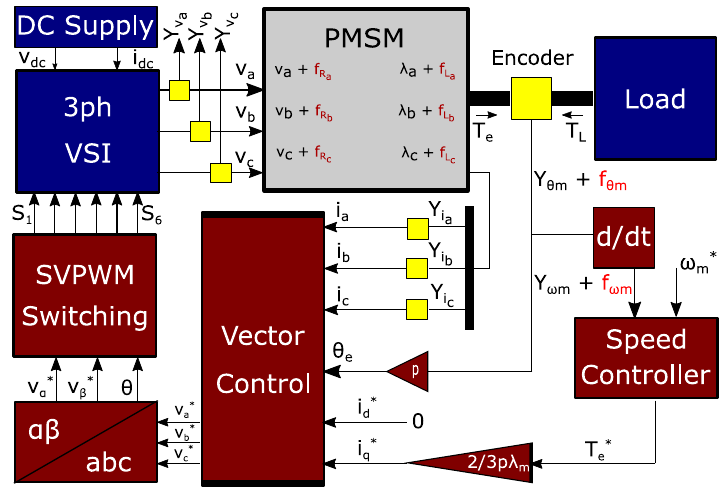
Figure 2. Modeling diagram of PMSM and drive